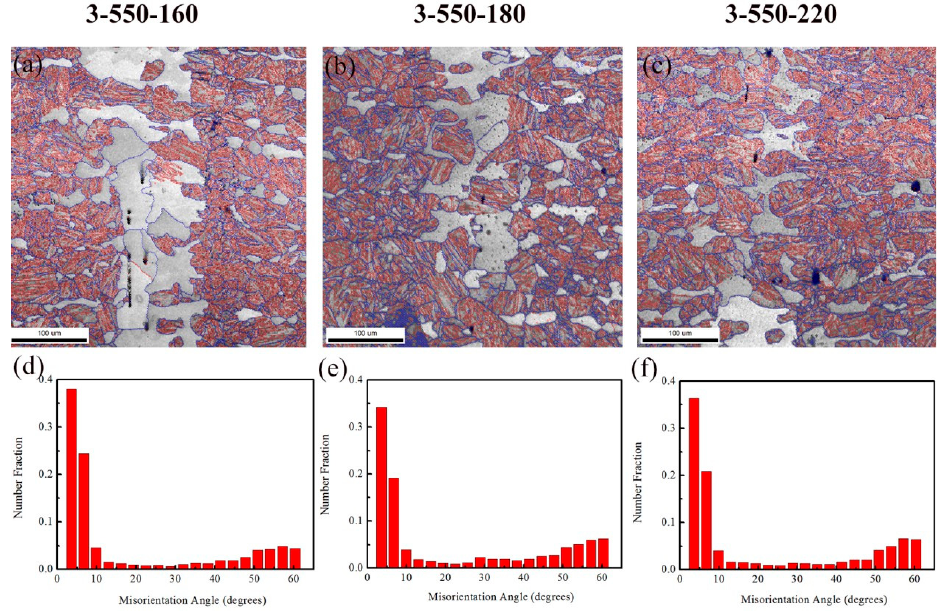
Figure 12. The EBSD results of the weld zone of the creep samples for different stresses: ( a – c ) are grain-boundary distribution maps; ( d – f ) are orientation-difference statistics diagrams.